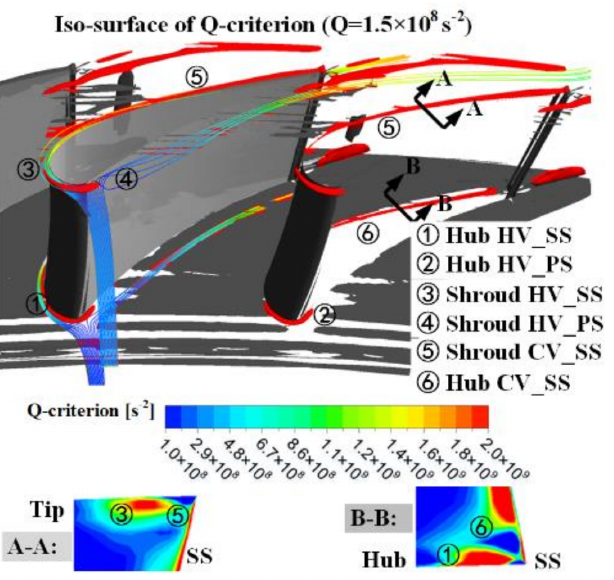
Figure 16. Vortex structure of case with only hot streak (iso-surface of Q-criterion, Q = 1.5 × 10 8 s − 2